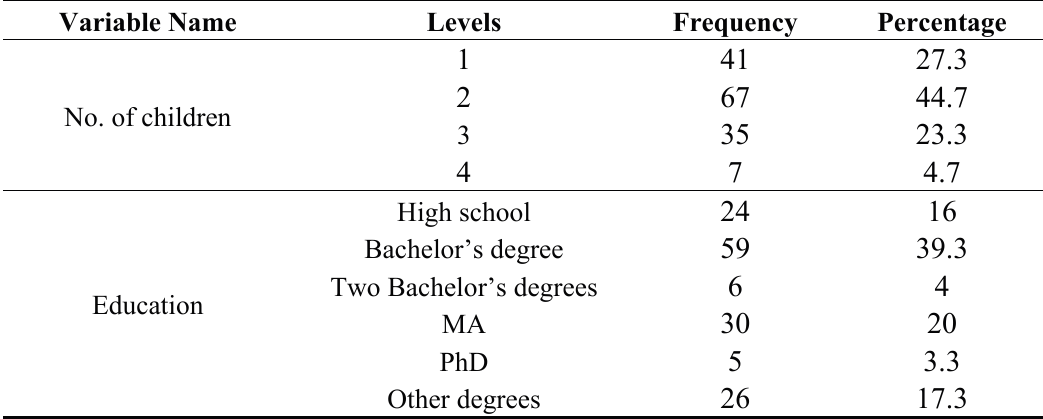
Table 1. Demographic variables of the study population: Nominal variables (N =